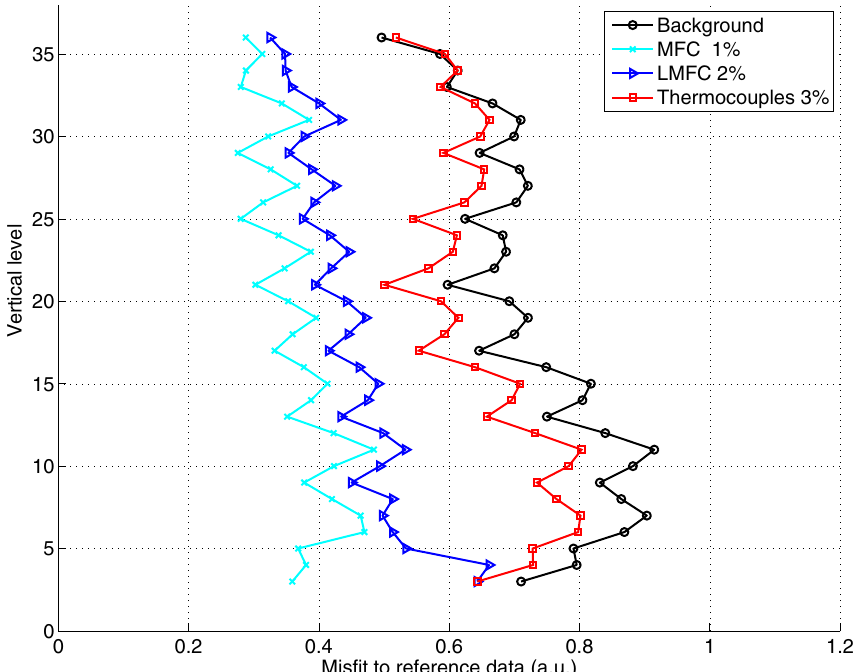
Fig. 4. Vertical mis fi t for various kind of intruments, measured by the RMS of the differences between the analysis and the measurements at unused locations (see text for details).